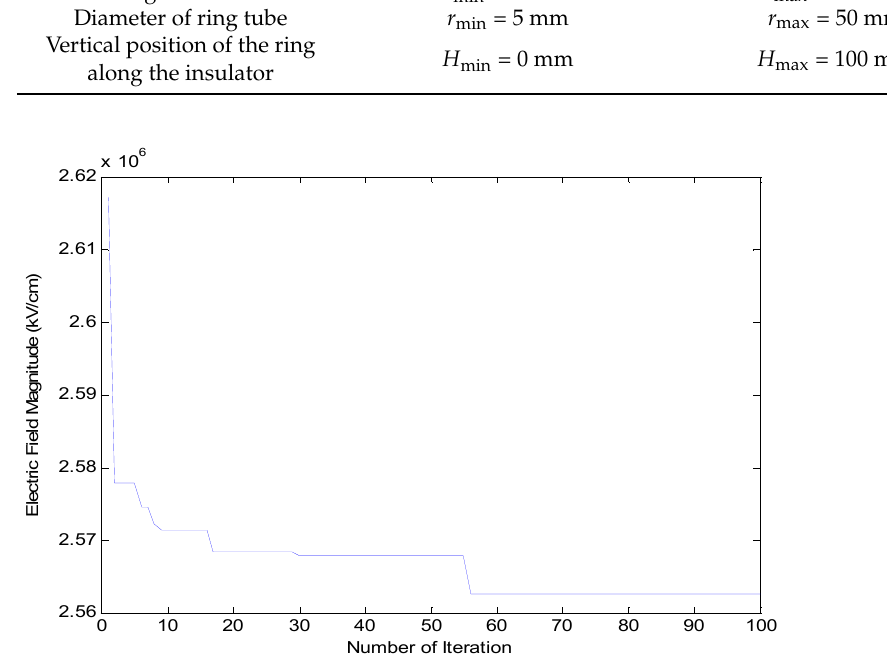
Figure 13. Simulation results for GWO after 100 iterations.